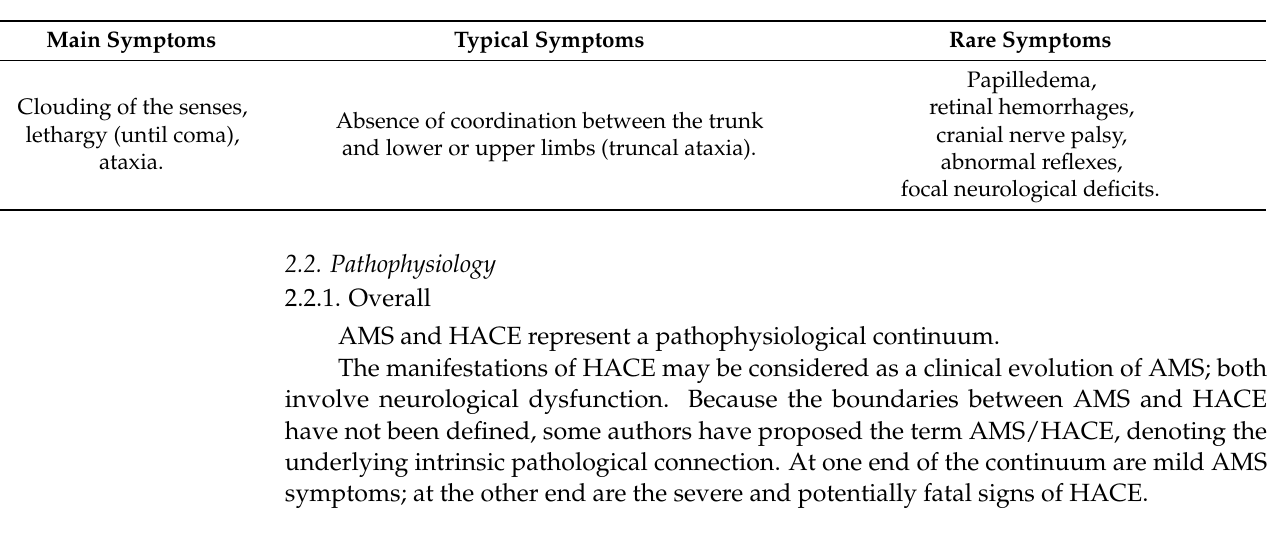
Table 2. Symptoms of